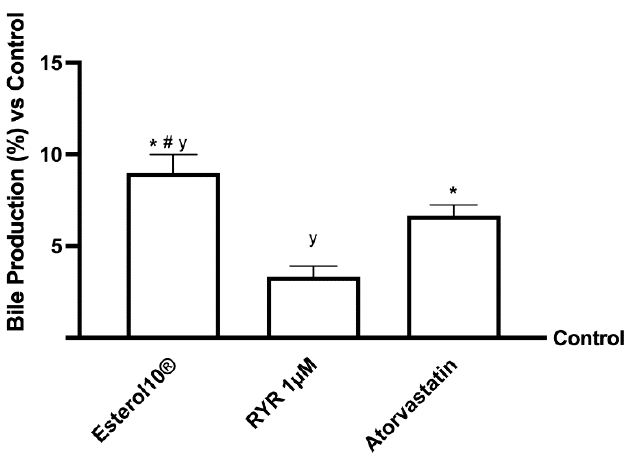
Figure 4. Bile acid production following treatment of hepatic in vitro model. The abbreviations are the same as reported in Figure 1. Data are mean ± SD of five independent experiments performed in triplicate. * p < 0.05 vs. control; # p <0.05 vs. RYR and y p < 0.05 vs. Atorvastatin.